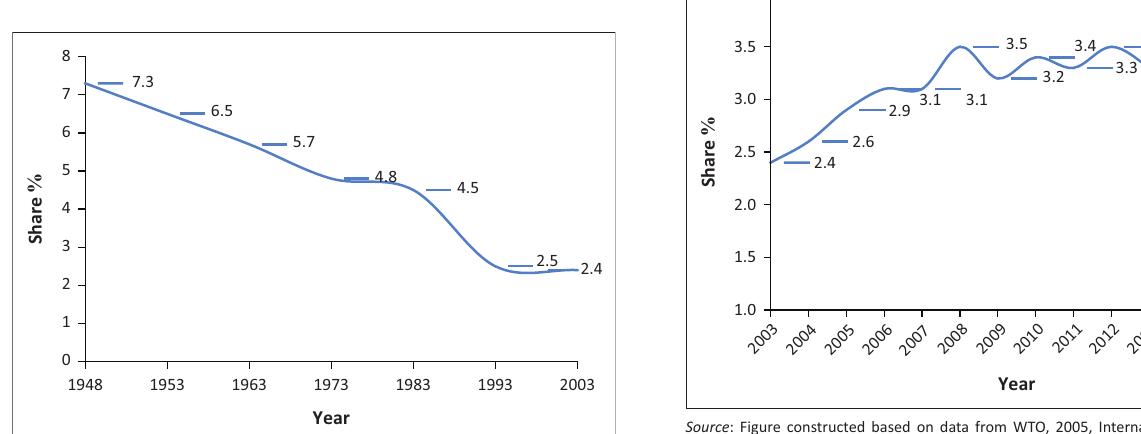
Source : Figure constructed based on data from WTO, 2005, International trade statistics 2005, World Trade Organization, Switzerland; WTO, 2015, International trade statistics 2015, World Trade Organization, Switzerland; WTO, 2017, World trade statistical review 2017, World Trade Organization, Geneva. FIGURE 2: African merchandise export’s share of global export